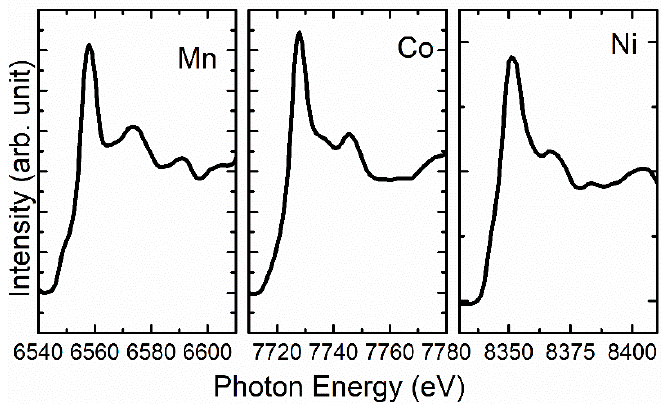
Figure 2. X-ray absorption near-edge spectroscopy (XANES) spectra at the Mn, Co, and Ni K -edges extracted (bulk mode) from transmission X-ray microscopy (TXM) images for NMC811 cathode